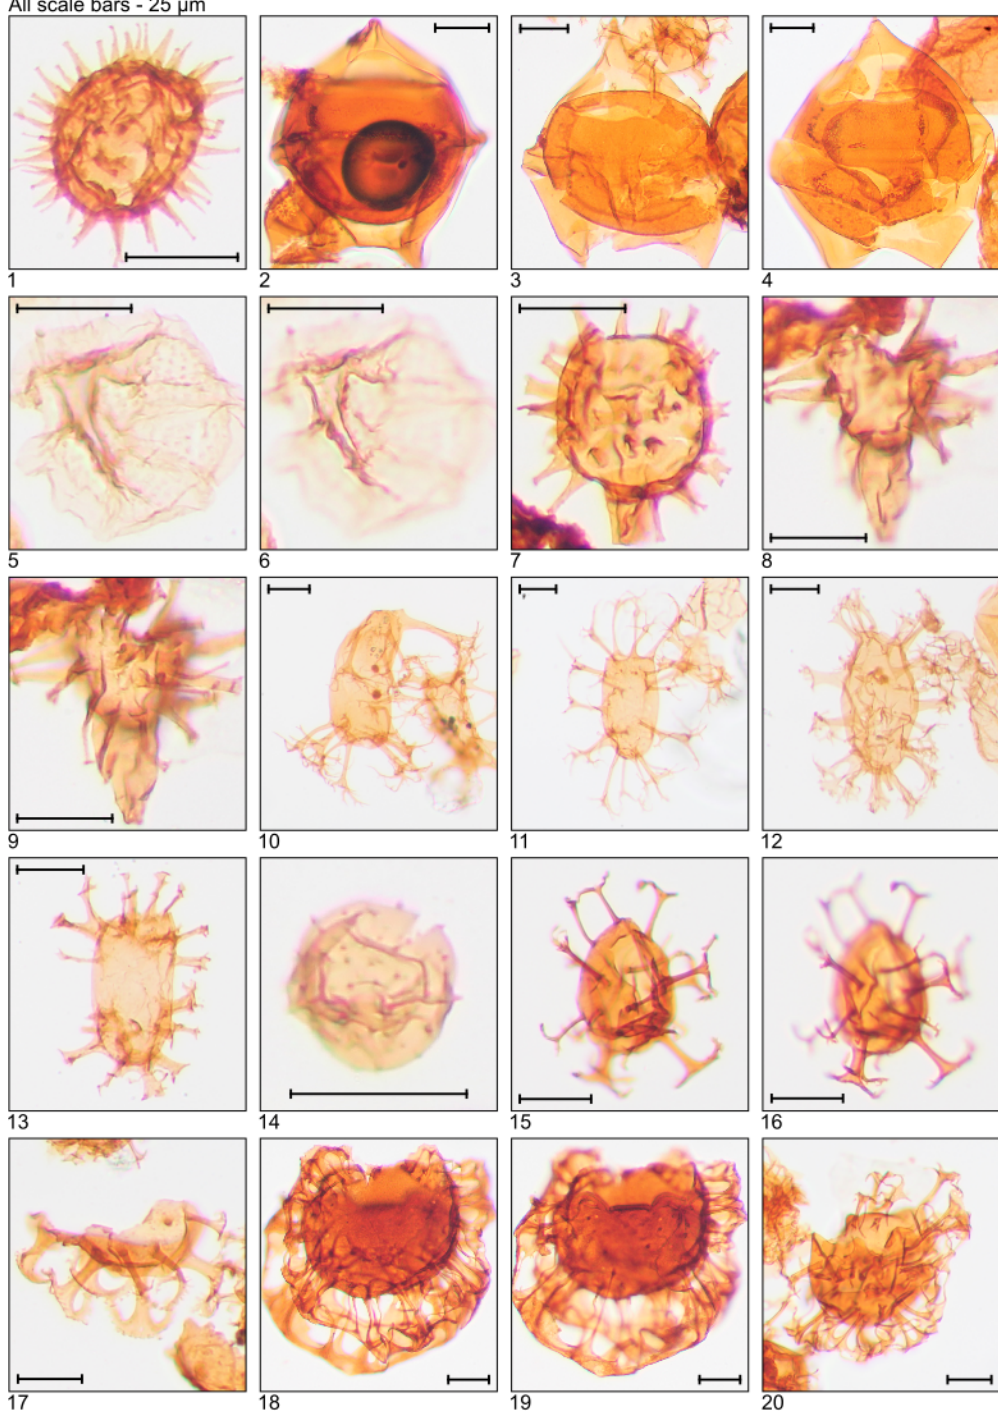
Plate 2. Illustration of taxa and sample or slide number. (1) Dapsilidinium pastielsii (MG391; 119.2m; D11). (2) Deflandrea